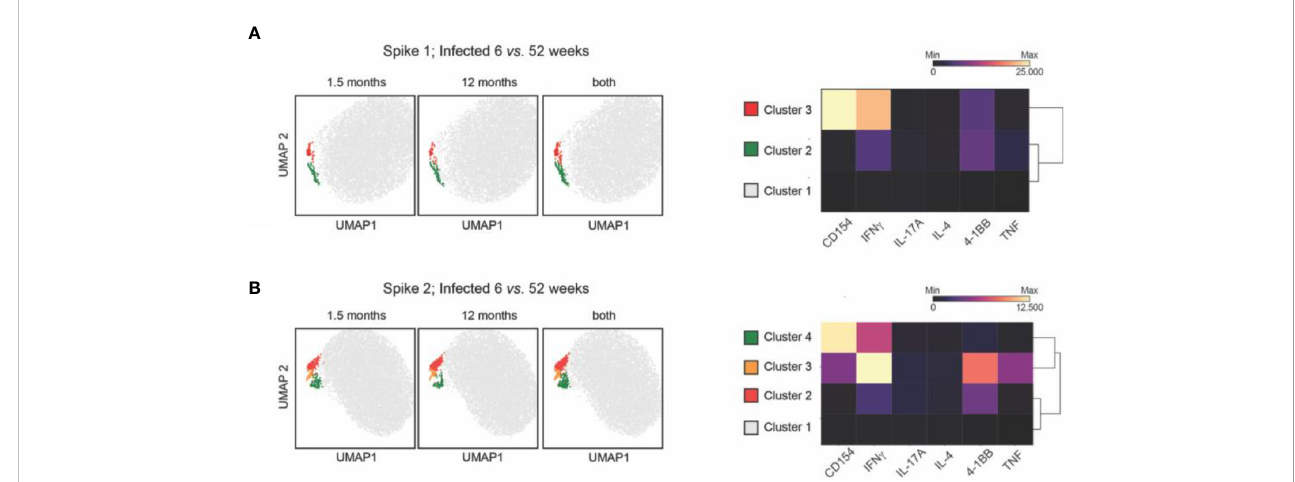
FIGURE 4 Multi-dimensional fl ow cytometry analyses using UMAP and FlowSOM clustering. Dot plots depict global UMAP projection pooled from CD3 + CD4 + T cells from the study participants. For the fi rst two maps, dot plots from each group are shown followed by a third dot plot with clusters identi fi ed with FlowSOM clustering using pooled CD3 + CD4 + T cells from the compared groups. Heatmaps depict Median Fluorescence Intensity (MFI) values as indicated by clusters and markers. (A) S.1 and (B) S.2-speci fi c T H response in infected individuals for 1.5 versus 12 months. CD: cluster of differentiation; IL: interleukin; INF: interferon; TNF: tumor necrosis factor; UMAP: Uniform Manifold Approximation and